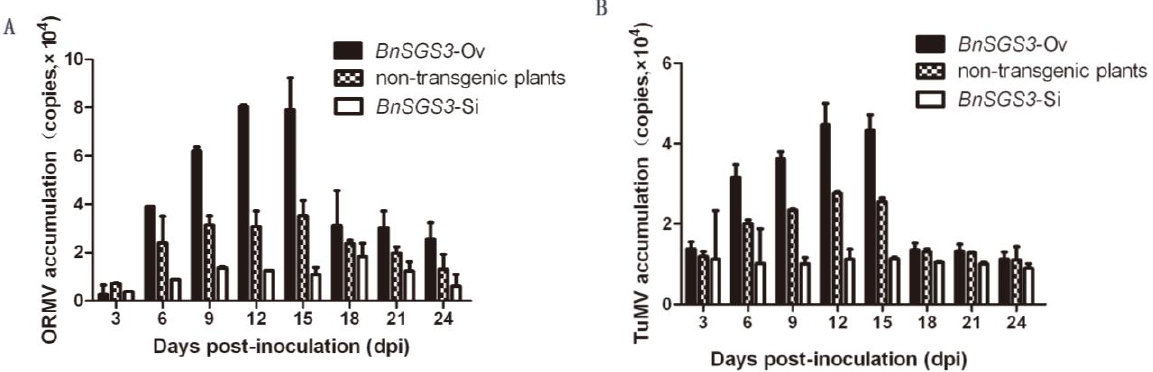
Figure 5. Figure 5. Cont.